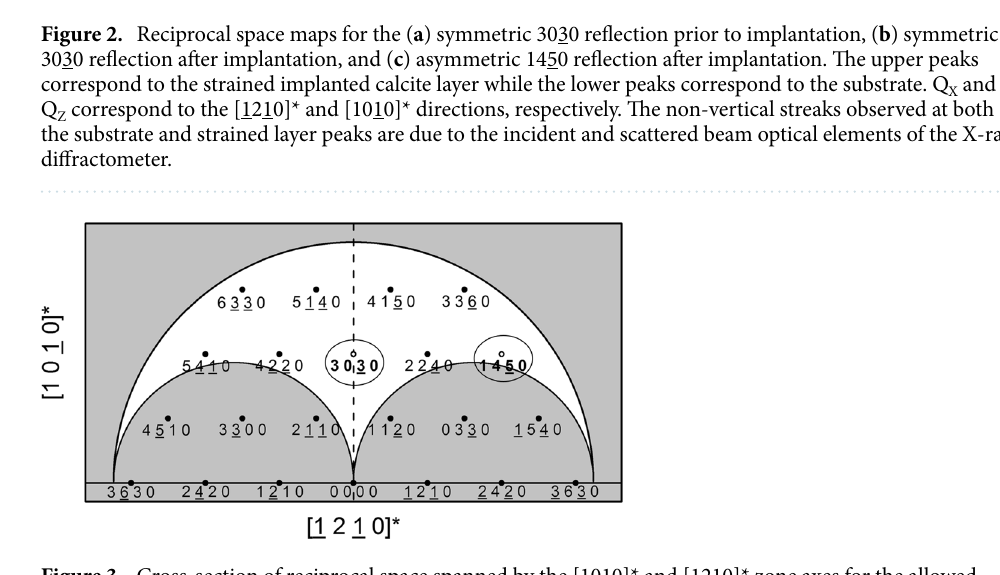
Figure 3. Cross-section of reciprocal space spanned by the [1010]* and [1210]* zone axes for the allowed reflections of calcite. The open circles indicate peaks measured in this study. The outer shaded region corresponds to the Cu Kα 1 limiting sphere and the two inner shaded regions correspond to transmission geometry